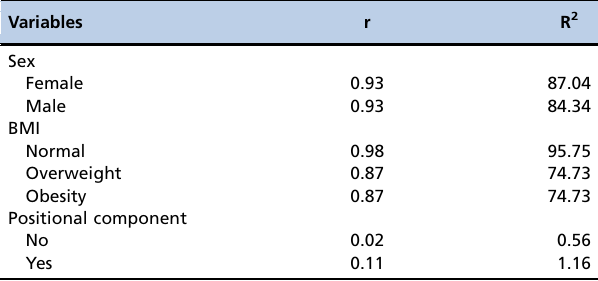
Table 2 - Correlation between oxyhemoglobin desaturation index (ODI) and apnea-hypopnea index (AHI) according to sex, body mass index (BMI), and the positional